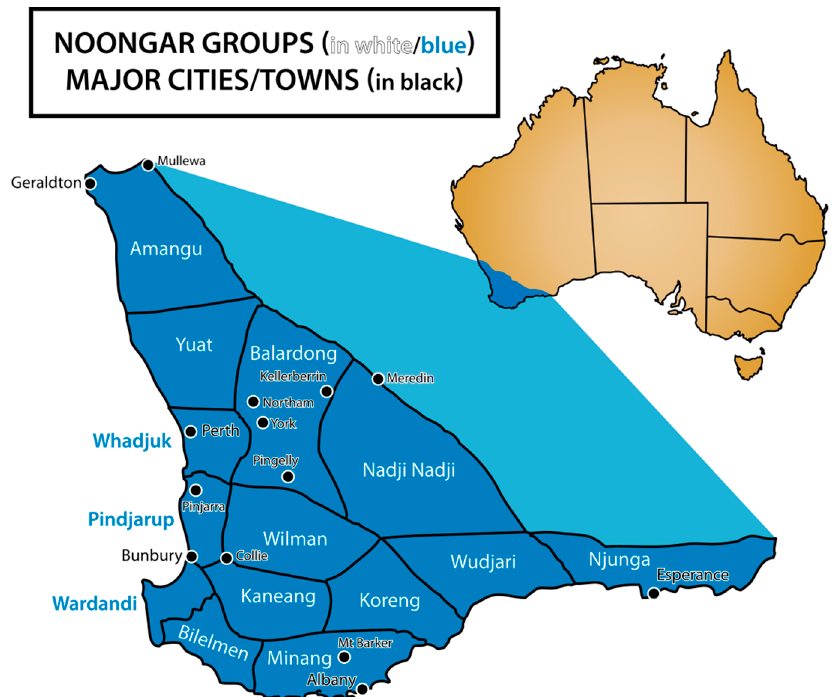
Figure 1. Nyoongar groups that make up the Nyoongar Nation in the lower southwest of Western Australia. Image by Brooke Ottley. Reproduced under the Creative Commons Attribution—Share Alike 3.0 Unported License, 2011. Image source: https://en.wikipedia.org/wiki/File:Noongar_regions_map.svg (accessed on 29 June 2021).